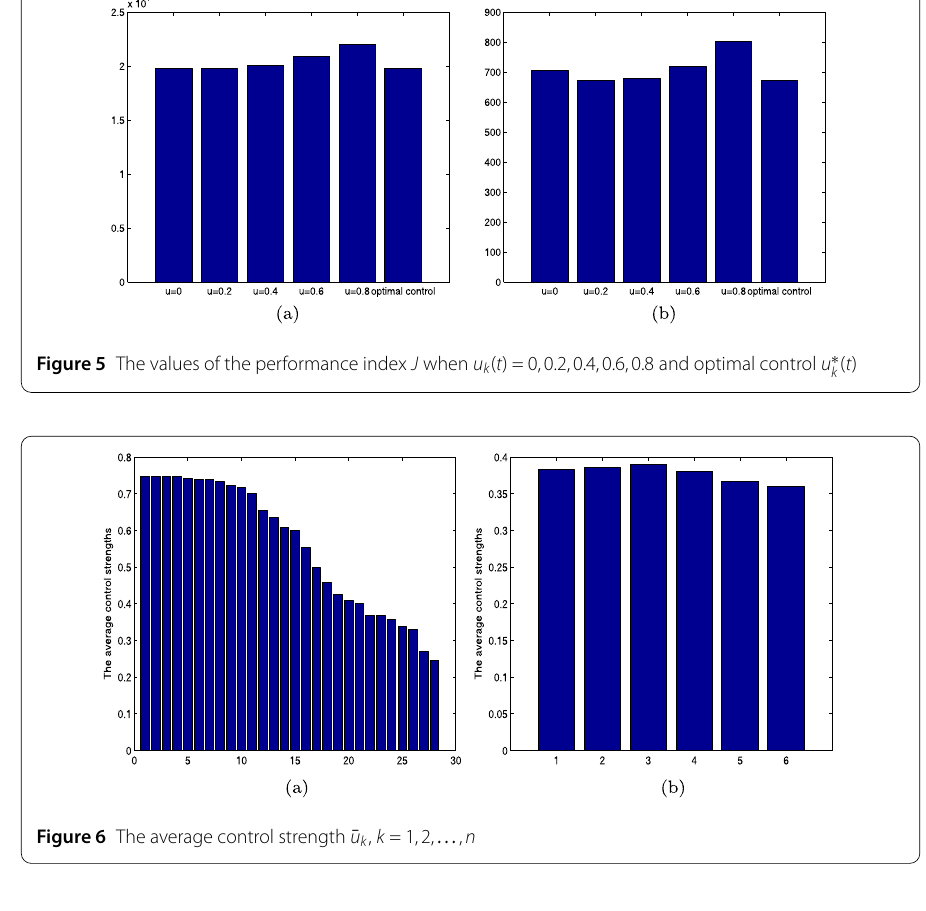
optimal control strategy indeed makes the objective function J achieve the minimal value, which is consistent with the theoretical